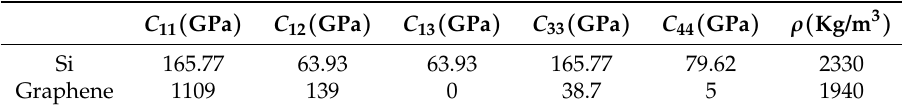
Table 1. Elastic parameters of Si and